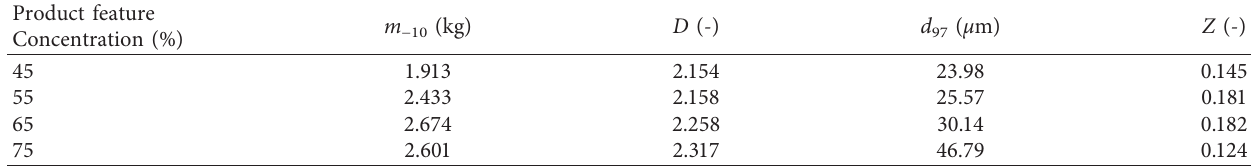
Table 3: Variation of product feature at different concentrations.